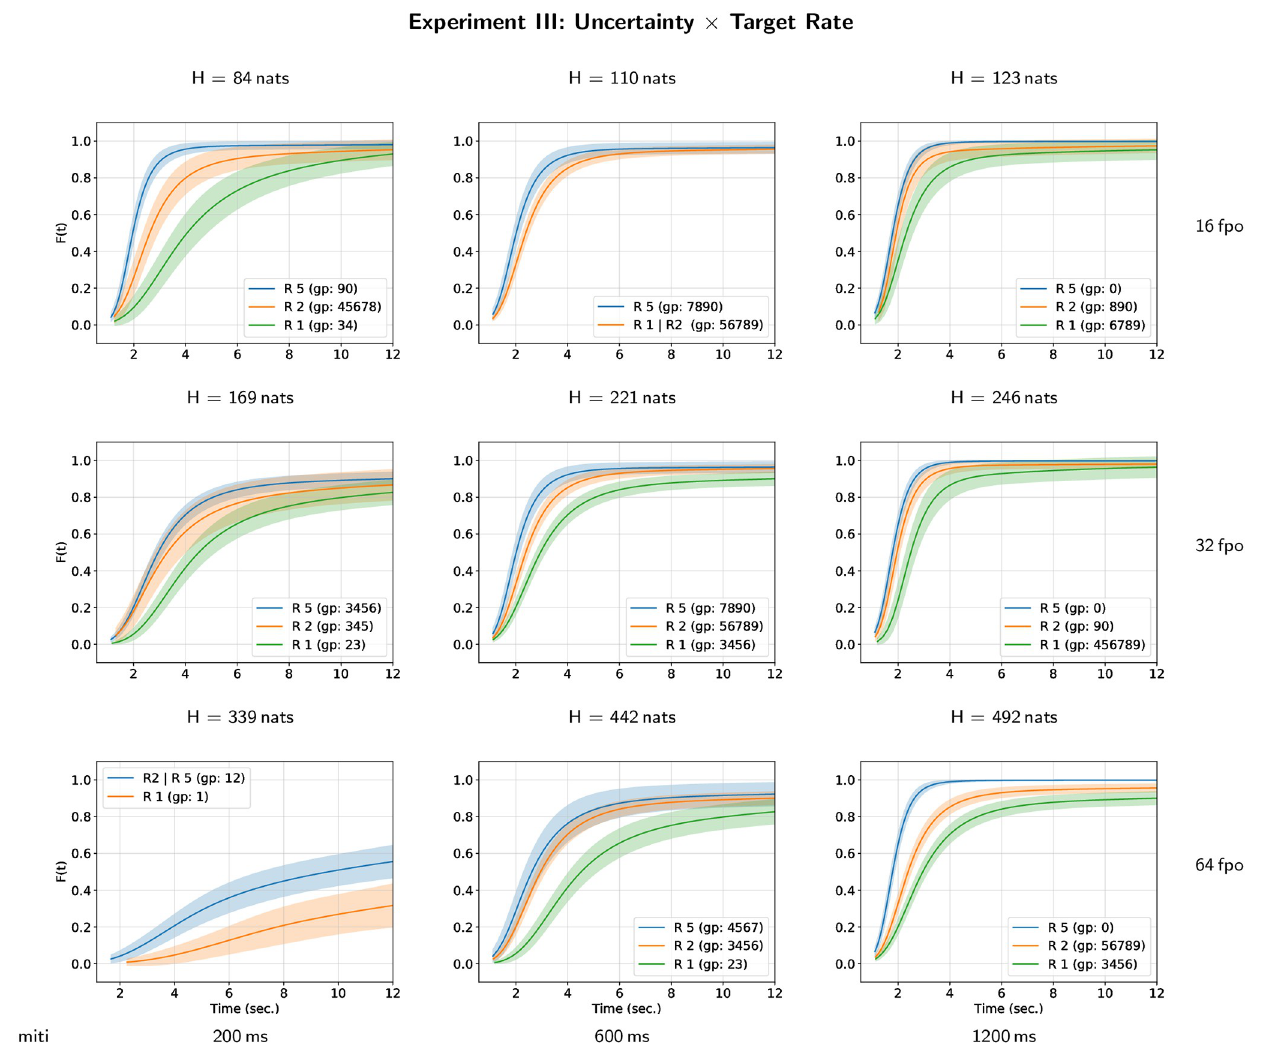
Fig 8. Cumulative distribution functions F ( t ) for masker uncertainty and target repetition rate in Experiment III. Each figure depicts the estimates of the cumulative distribution functions for each different group of the compact letter display for experimental conditions defined by the interaction between masker uncertainty and target repetition